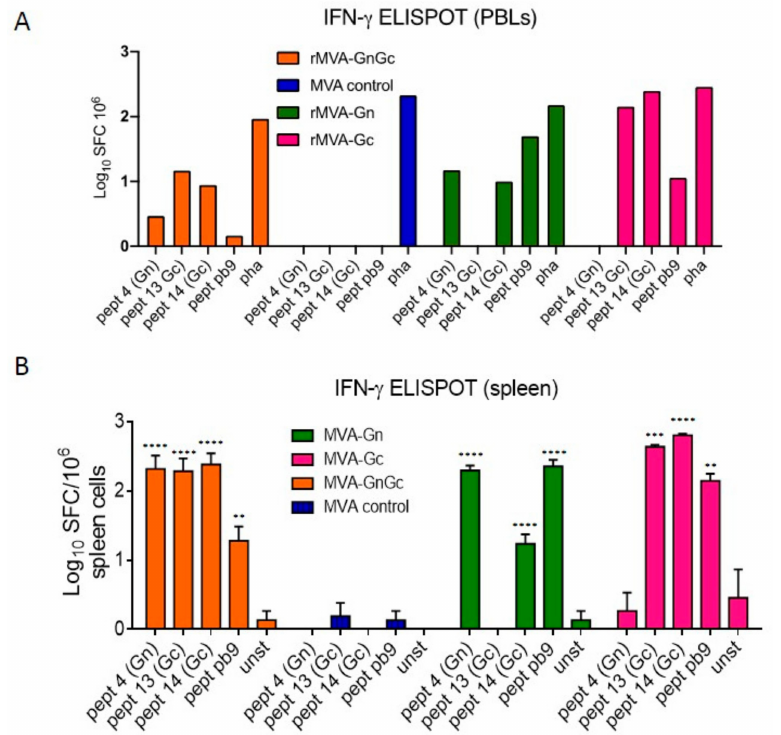
Figure 4. Cellular responses upon MVA immunization. ( A ). Interferon gamma ELISPOT assay of pooled ( n = 5) BALB / c peripheral blood leukocytes (PBLs) taken at day 14 postimmunization with